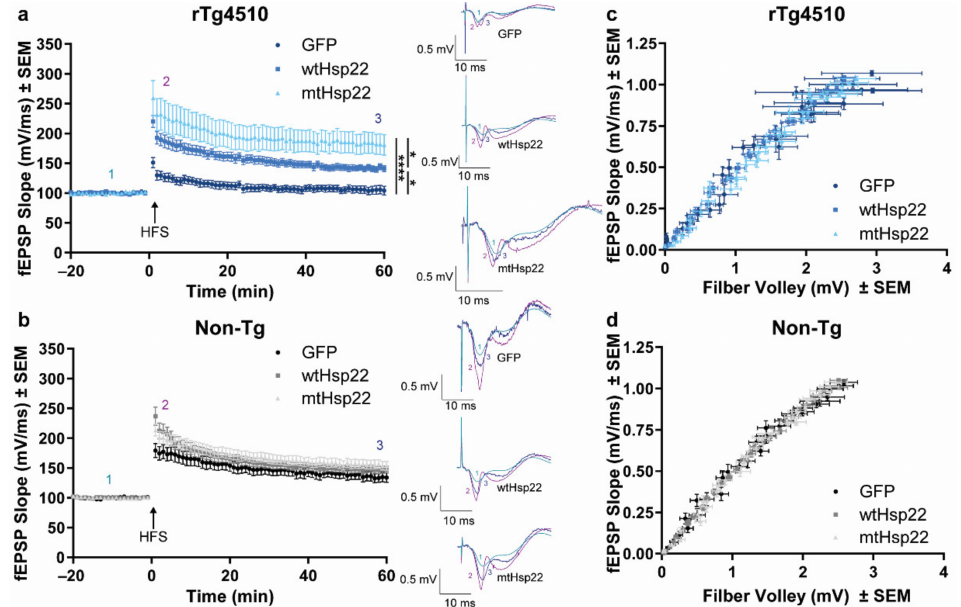
Figure 3. Hsp22 overexpression increases synaptic plasticity in rTg4510 mice. After recording a 20-min baseline, long-term potentiation (LTP) was induced in the Schaffer collaterals with high- frequency stimulation (HFS) (5 bursts of 200 Hz separated by 200 ms, repeated 6 times with an intertrain interval of 10 s). fEPSP was recorded for 60 min in ( a ) rTg4510, and ( b ) non-transgenic (Non- Tg) mice injected with GFP ( n = 4/Non-Tg; n = 4/rTg4510), wtHsp22 ( n = 4/Non-Tg; n = 4/rTg4510), or mtHsp22 ( n = 4/Non-Tg; n = 4/rTg4510) (mean ± SEM, * p < 0.05, **** p < 0.0001). Representative traces are shown: 1 (teal) indicates baseline, 2 (pink) indicates early LTP potentiation in the first 3 min following HFS, and 3 (blue) indicates late LTP in the last 3 min of recording. The input/output curves of the fEPSP slope (mV/ms) versus the fiber volley amplitude (mV) in ( c ) rTg4510 and ( d ) Non-Tg mice injected with GFP, wtHsp22, or mtHsp22 (mean ±